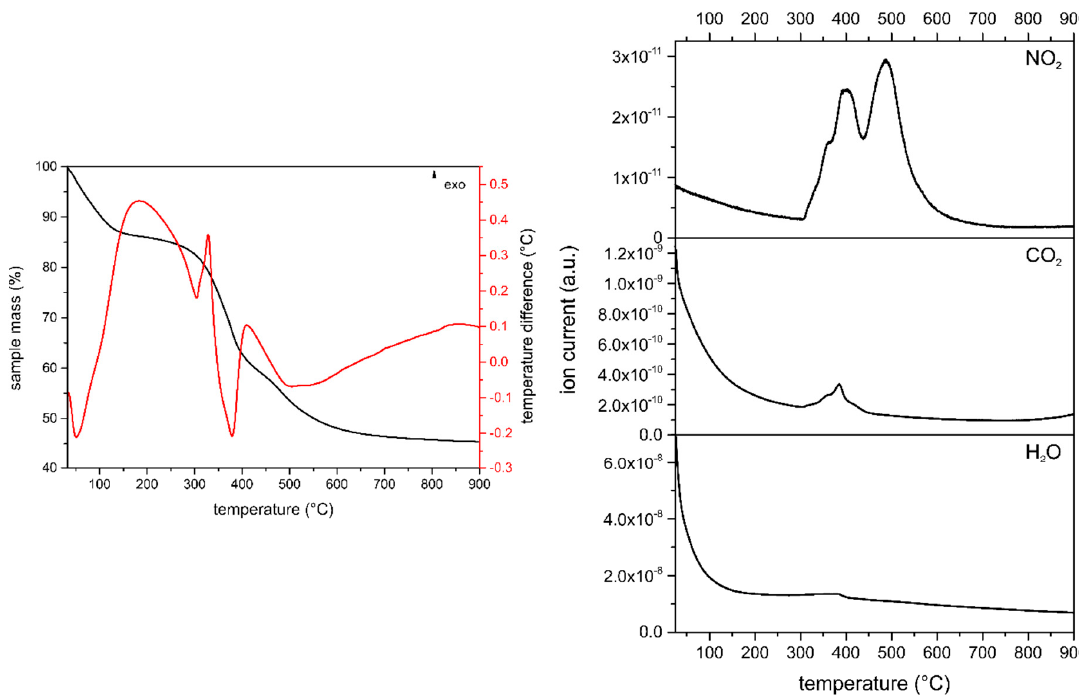
Figure 2. Thermogravimetric Analysis-Differential Thermal Analysis-Mass Spectrometry (TG-DTA-MS) of sample MA-fluo2.